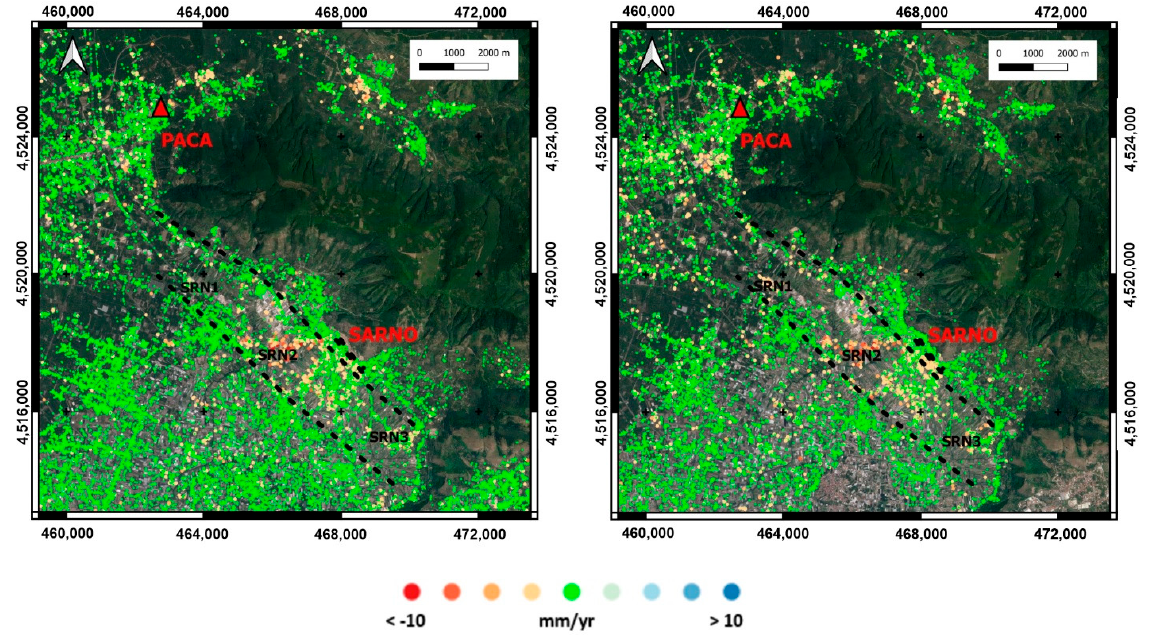
Figure 11. Mean displacement rate map for ENVISAT images (2003–2010 period): ( a ) ascending and ( b ) descending. Red triangle indicates location of GNSS Palma Campania (PACA).